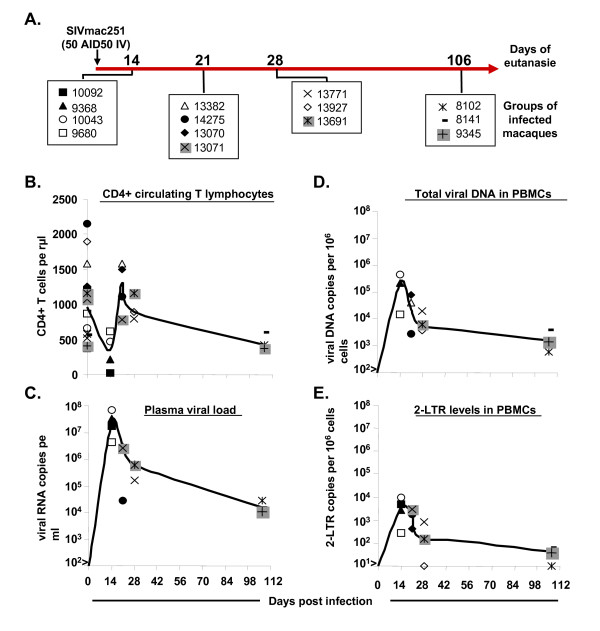
Changes in CD4+ T cell numbers as a function of viral replication and dissemination in the peripheral blood, in four groups of SIV-infected macaques during primary infection. (A) Protocol for SIV infection, evaluations, and the euthanasia of each animal. Each box indicates the group of macaques explored at the corresponding times. (B) Changes in absolute counts of total CD4+ T cells in peripheral blood. (C-D-E) Changes in viral RNA levels in plasma and viral DNA and 2LTR circle levels in PBMCs. Bold lines indicate the mean value (B-D-C-E).